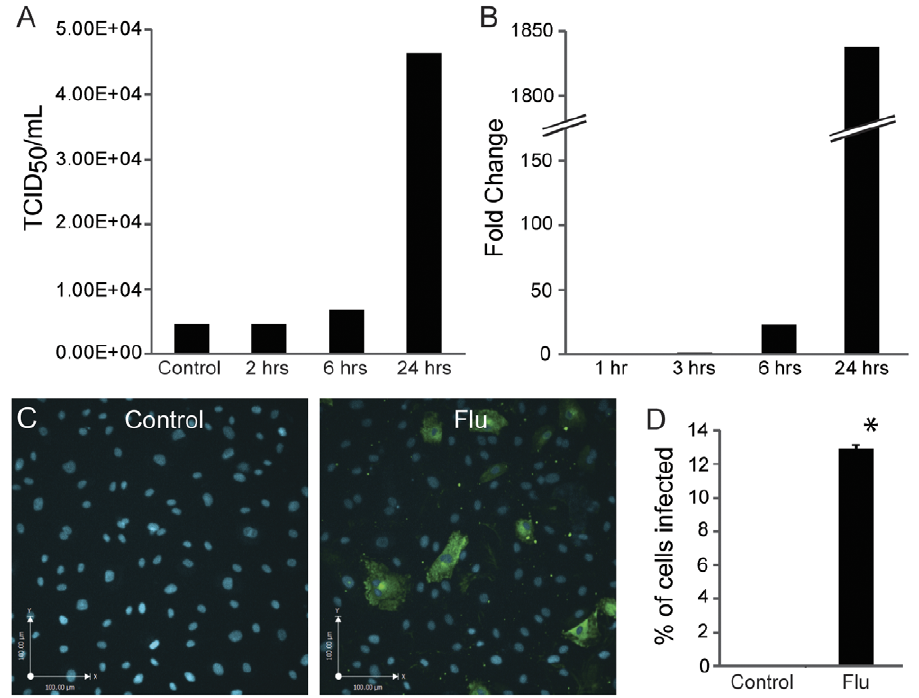
Figure 1. Human influenza replicates in primary lung microvascular endothelial cells. (A) Viral titer increases over time as shown by TCID 50 assay. This assay quantitates the ability of influenza to agglutinate red blood cells after viral replication (see Materials and Methods section for further details). The initial influenza dose was 25 HAU/100 000 cells. The control group had no cells, received the same influenza dose, and was analyzed at 24 hours. Results are representative of 3 experiments. (B) qPCR showing the fold change in viral RNA for the influenza A M1 protein (see Materials and Methods for primers) over time. Results are representative of 3 experiments. (C–D) Immunofluorescent images (C) and quantitation (D) showing the percentage of cells infected by influenza after 24 hours. Influenza was given at 40 HAU/100 000 cells. Nuclei are stained with DAPI and viral nucleoprotein is shown in green. Images are representative of 3 experiments; data are mean and standard error, *p , 0.05 for flu vs. control (uninfected